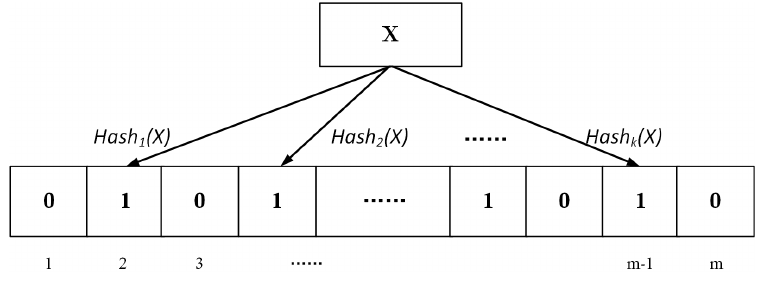
Figure 1. Illustration of a bloom filter checking an element